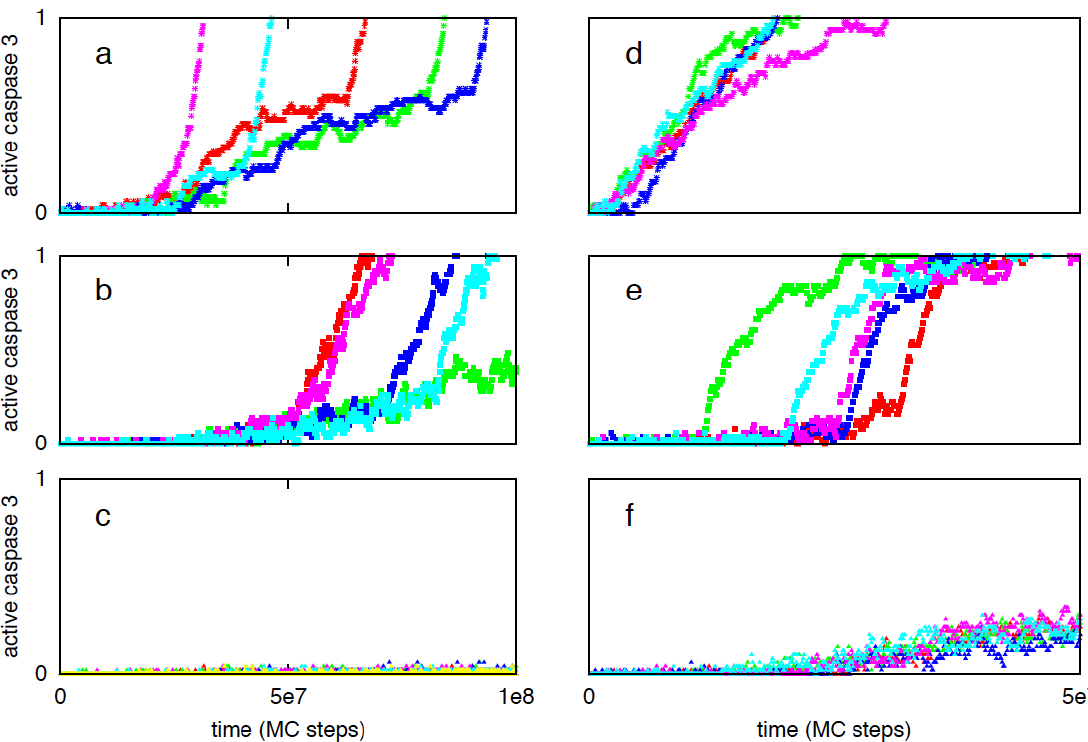
Figure 12. Time course of caspase 3 activation in cancer cells having over-expressed Bcl2 and XIAP. Bcl2 over-expression is taken as ~50-fold while XIAP expression is varied: normal ( a and d ), 3-fold ( b and e ), 5-fold ( c and f ). Such high Bcl2 expression can result from combined effect of various Bcl2 like anti-apoptotic proteins (also possibly found in cancer stem cells). Two different caspase 8 concentrations are used: 1 nM (left panel: a , b , c ) and 10 nM (right panel: d , e , f ). Data is shown for five representative single cells in each of the above cases; each color corresponds to apoptosis activation for a single cell (Monte Carlo